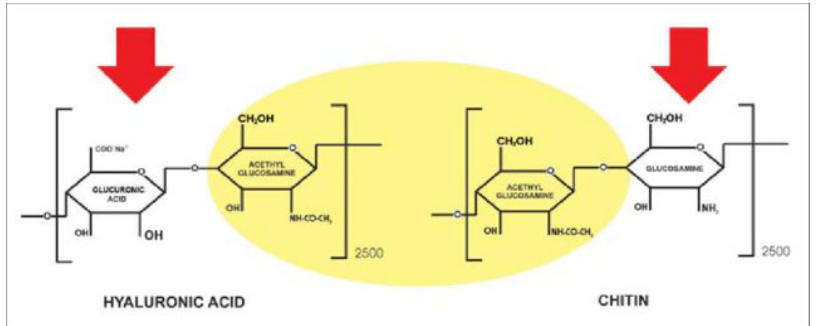
Figure 2. Chitin resembles the hyaluronic acid